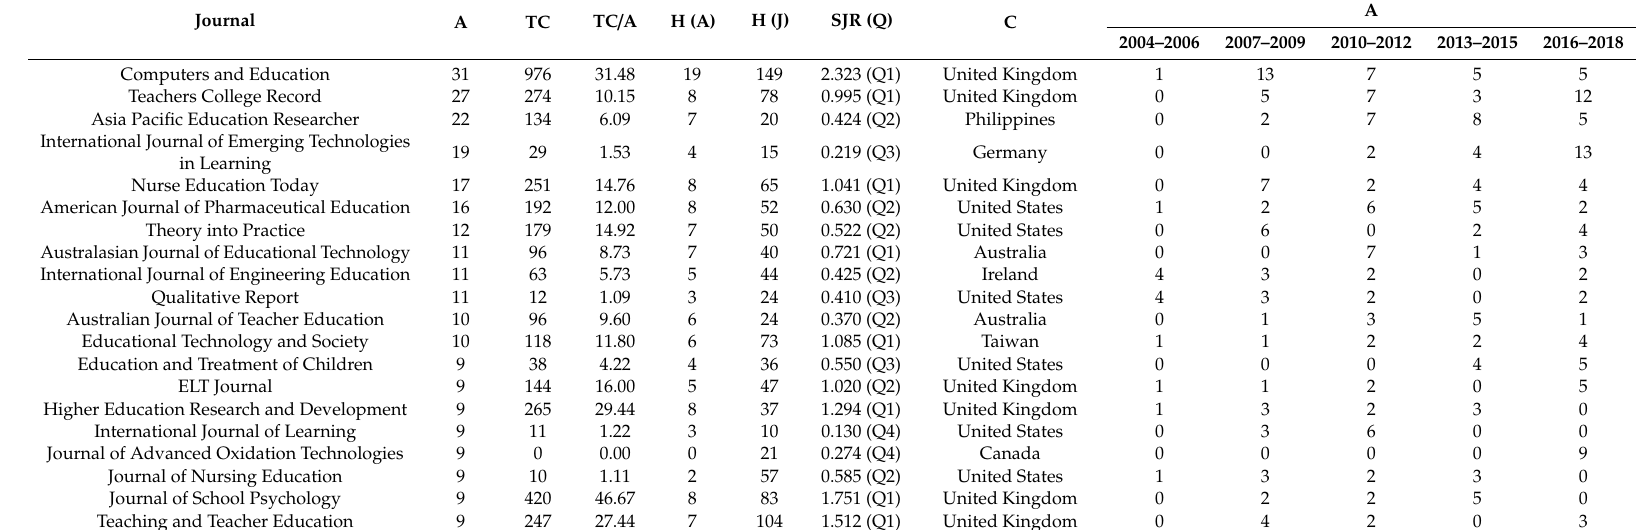
Table 4. Most productive journals in number of articles on the impact of the university classroom on managing the socio-educational well-being (2004–2018).